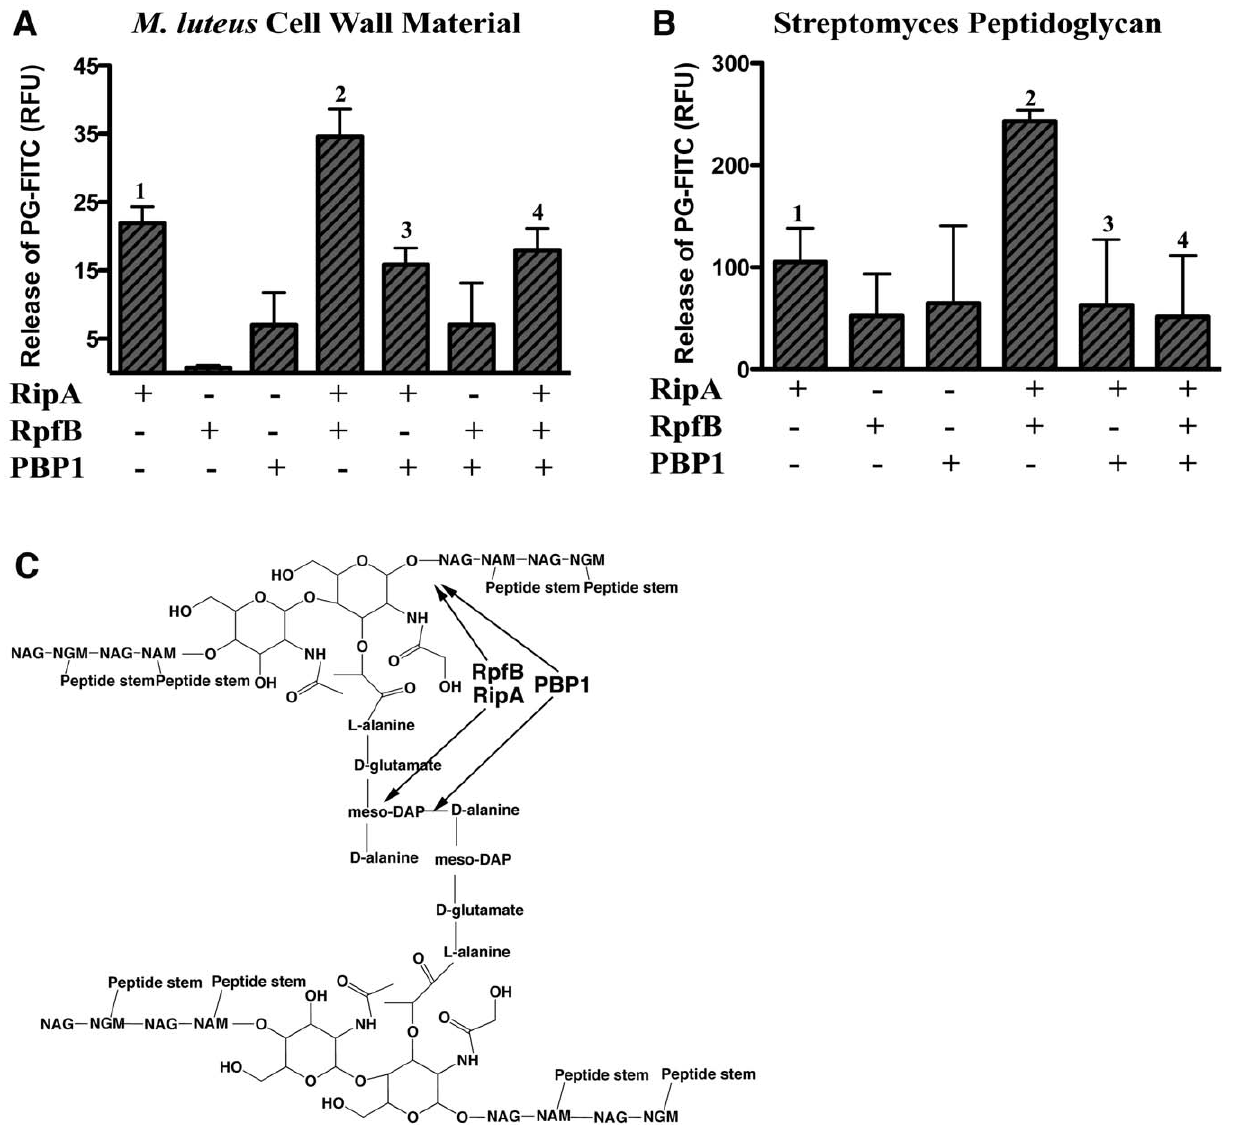
Figure 7. PBP1 inhibits the synergistic hydrolysis of cell wall by RipA-RpfB complex. N-terminal GST fusion proteins were expressed and purified from E. coli . Equal amounts of individual or combinations of proteins were incubated with insoluble FITC-labeled substrate: M. luteus cell wall material (A) or Streptomyces peptidoglycan (B). The extent of hydrolysis was determined by measuring the amount of soluble FITC remaining after centrifugation, and thus released during hydrolysis of the insoluble substrate. GST and buffer alone were used to determine background release of FITC and were subtracted from final values. Data are from representative experiments, each done in triplicate. Data are represented as mean + / 2 SEM. p-values for one-tailed, unpaired t-tests: (A) 1 vs. 2: 0.027 significant, 2 vs. 4: 0.016 significant, 1 vs. 3: 0.074 not significant, 1 vs. 4: 0.188 not significant, (B): 1 vs. 2: 0.009 significant, 2 vs. 4: 0.018 significant, 1 vs. 3: 0.279 not significant, 1 vs. 4: 0.240 not significant (significant to p , 0.05). (C) Schematic diagram of the basic structure of mycobacterial peptidoglycan, indicating where RpfB and RipA are predicted to have hydrolytic activity and where PBP1 is predicted to have synthetic activity. Lines connecting NAG to NGM represent b -1,4-glycosidic bonds, while lines connecting NGM to NGM represent peptide cross-linkages. NAG: N-acetyl glucosamine, NGM: N-glycolyl muramic acid, NAM: N-acetyl muramic acid (note that mycobacteria have a mixture of NGM and NAM, with the NGM structure shown here).